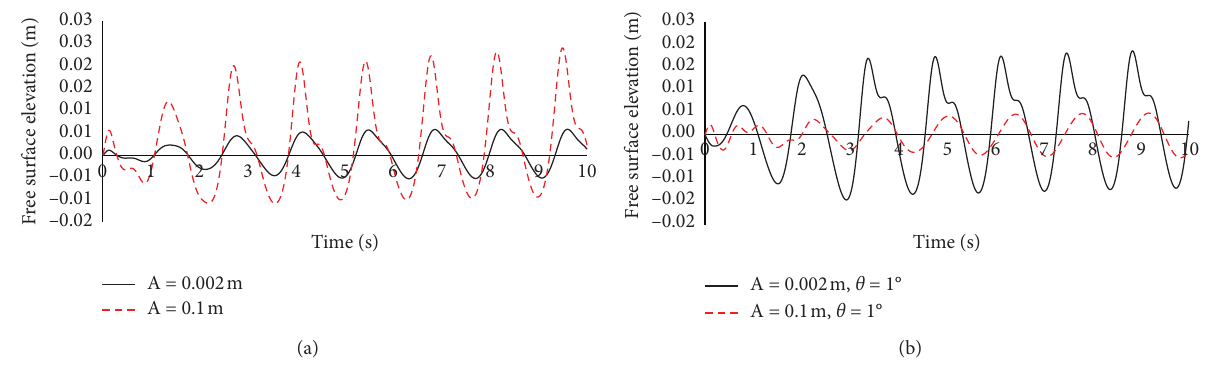
Figure 17: Comparisons of time history of free surface wave under (a) surge excitation; (b) coupled excitations of surge and pitch.